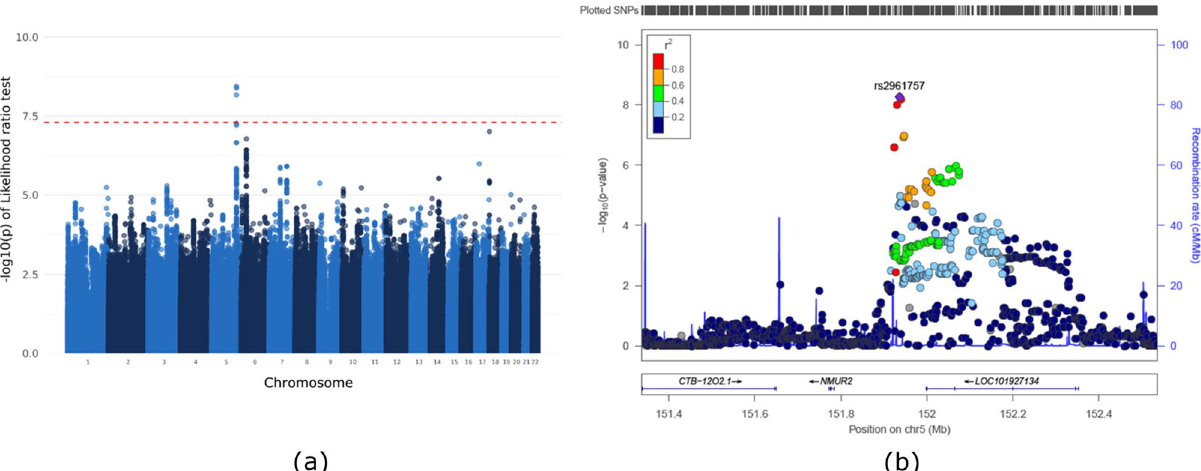
Figure 2. GWAS results for the Korean dataset. ( a ) Manhattan plot of the likelihood ratio test of the SNPs from chromosomes 1 to 22. ( b ) Expanded Manhattan plot of the 800 kb region shows both genotyped and imputed SNPs. rs2961757, which was the most significant SNP, and is indicated in purple, and other SNPs are colored according to their r 2 value relative to that of rs2961757. NMUR2 and LOC101927134 genes are located in this range.